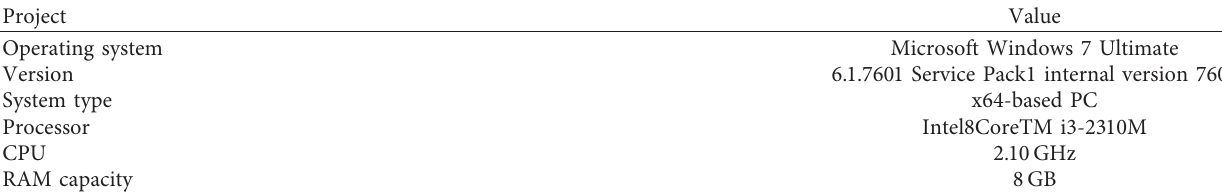
Table 3: Machine configuration during the system